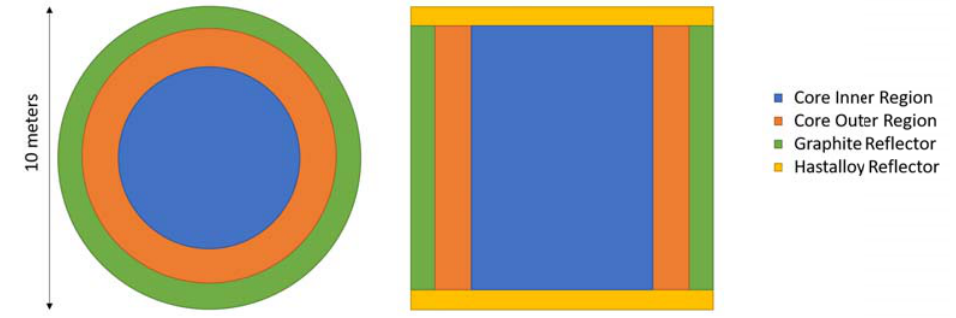
Figure 1: RZ model passed to